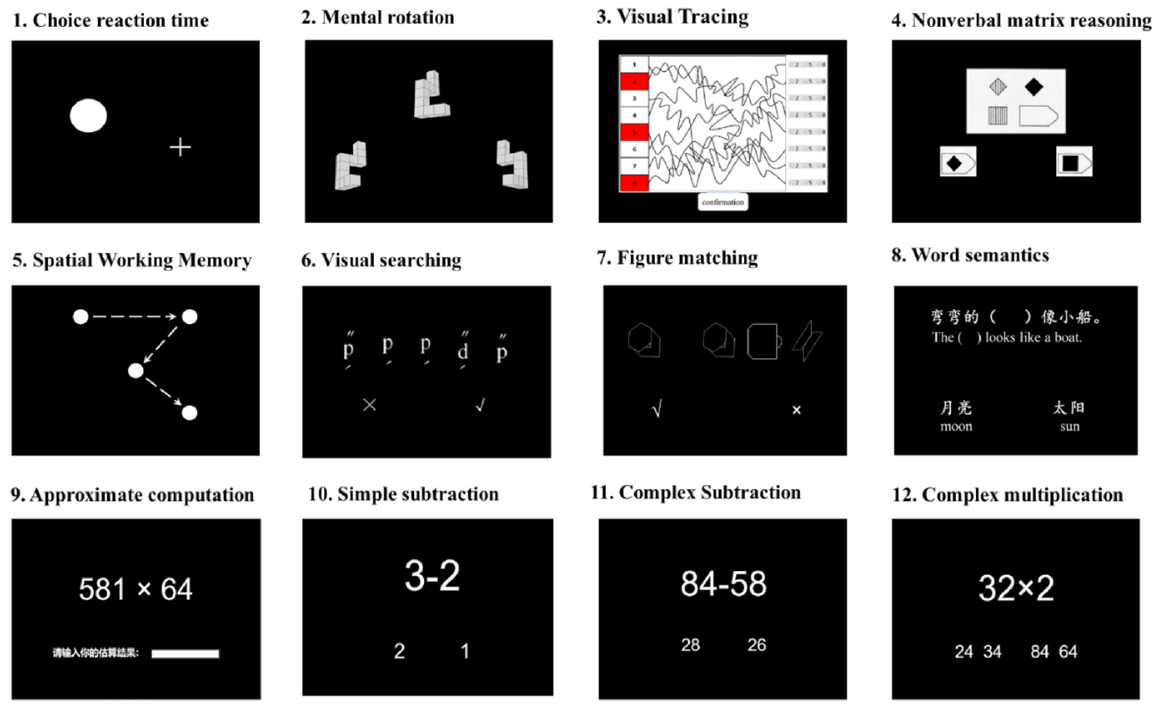
Figure 1. Display of a sample item for each test used in the current